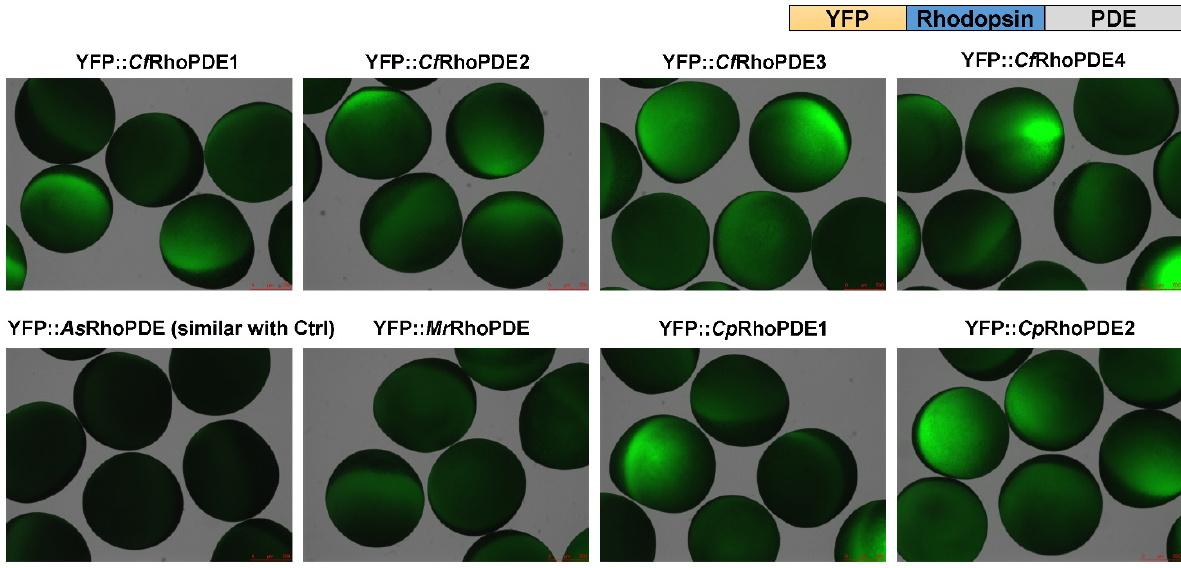
Figure 2. Expression of eight YFP ‐ RhoPDEs in oocytes. For each construct, 30 ng cRNA was injected into oocytes from the same batch. Fluorescence pictures were taken 3 dpi (days post